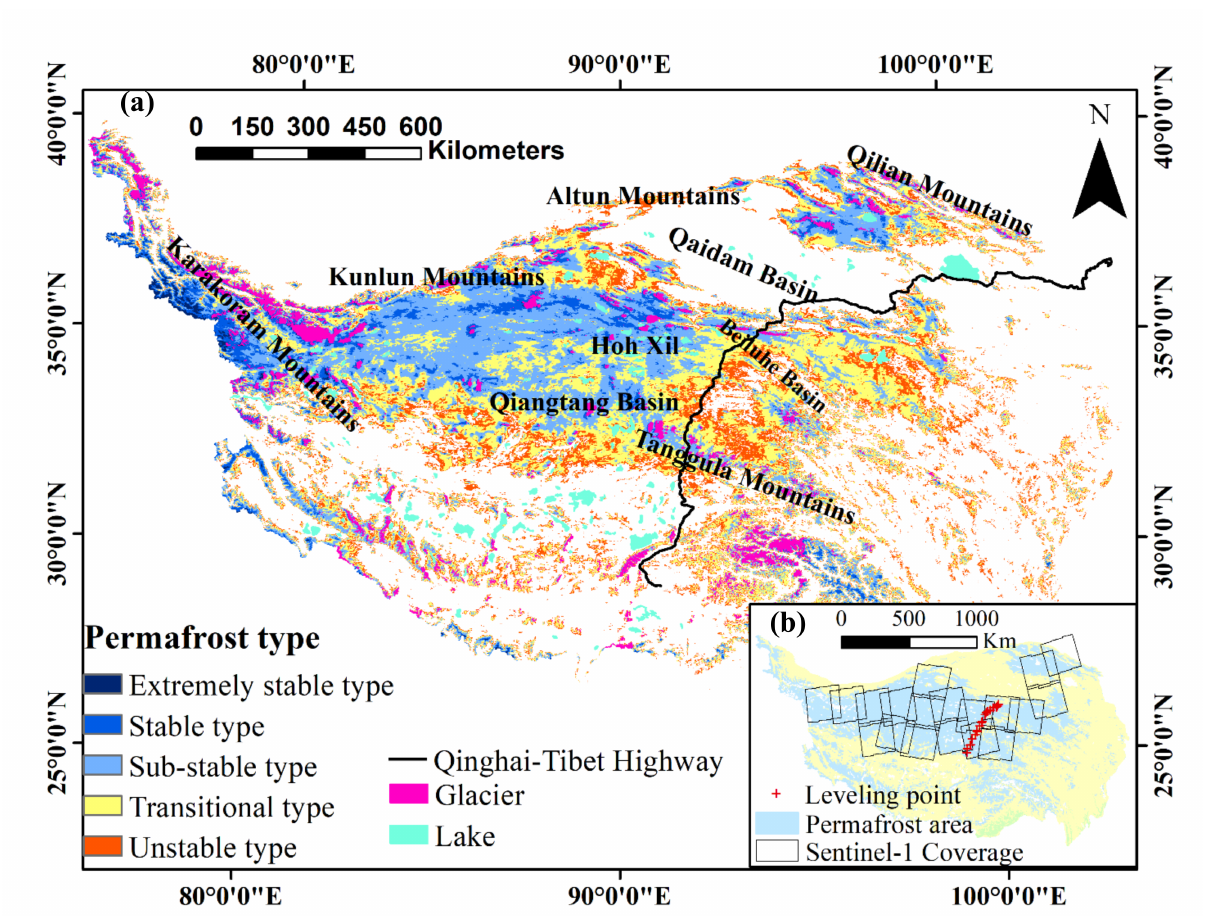
Figure 1. ( a ) Distribution map of different stability types of permafrost in QTP [27]; ( b ) The blue background shows the distribution of permafrost on the QTP [26], the black boxes show the areas covered by Sentinel-1 data, and the red plus signs mark the positions of leveling observation